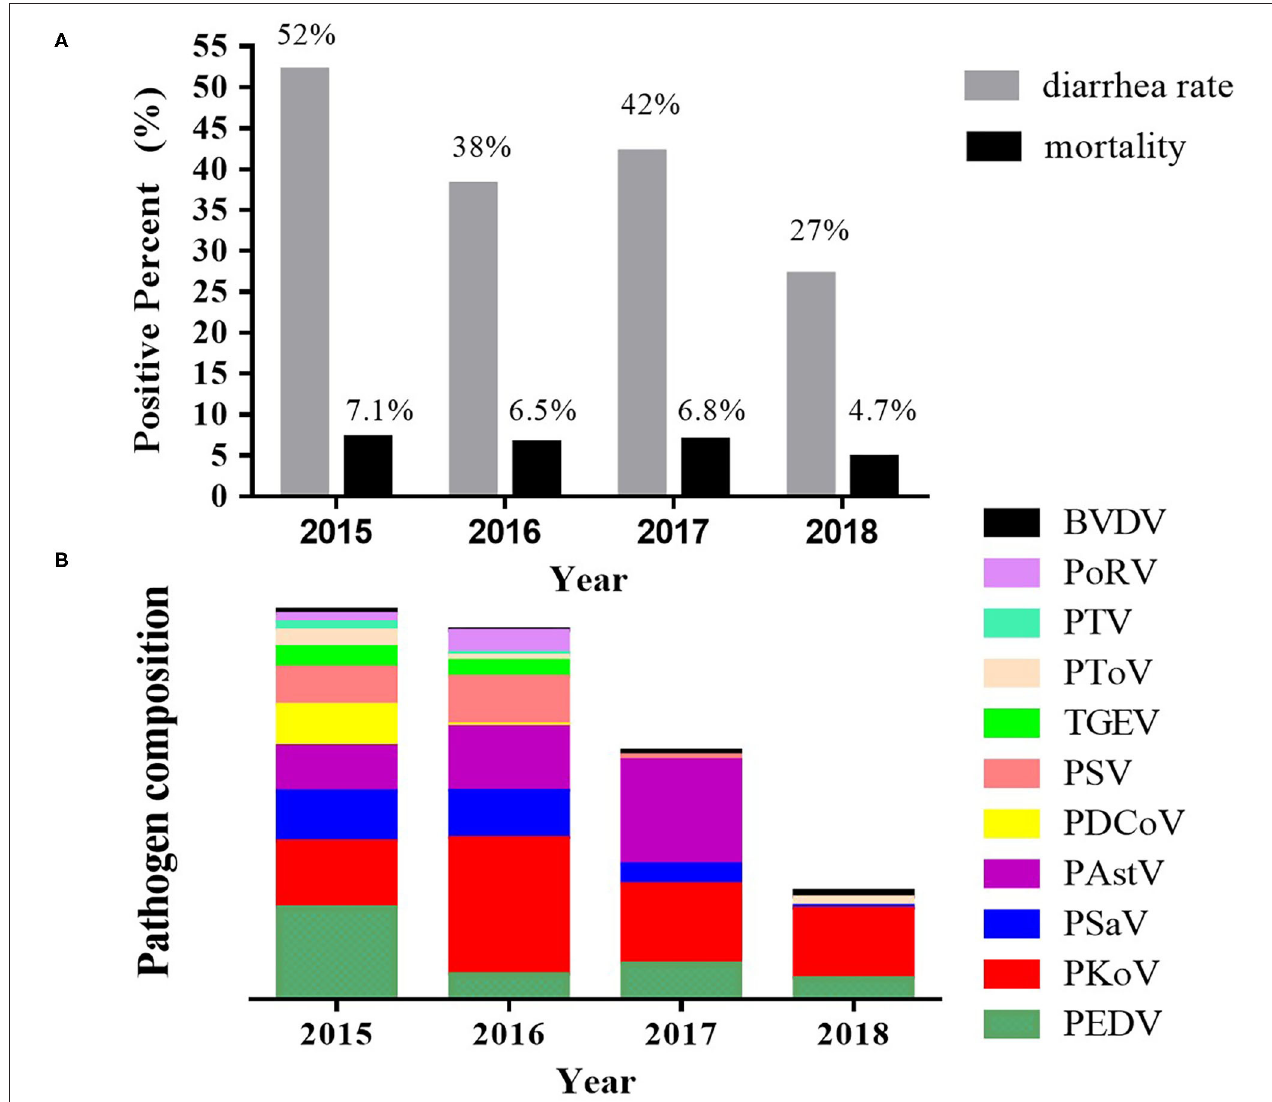
FIGURE 7 | Pathogen spectrum of a specific farm from 2015 to 2018. The porcine stool specimens were detected every year from 2015 to 2018. It was observed that the prevalence of the viral diarrhea pathogens also changed over time. (A) The diarrhea rate and mortality. (B) The pathogen composition in different